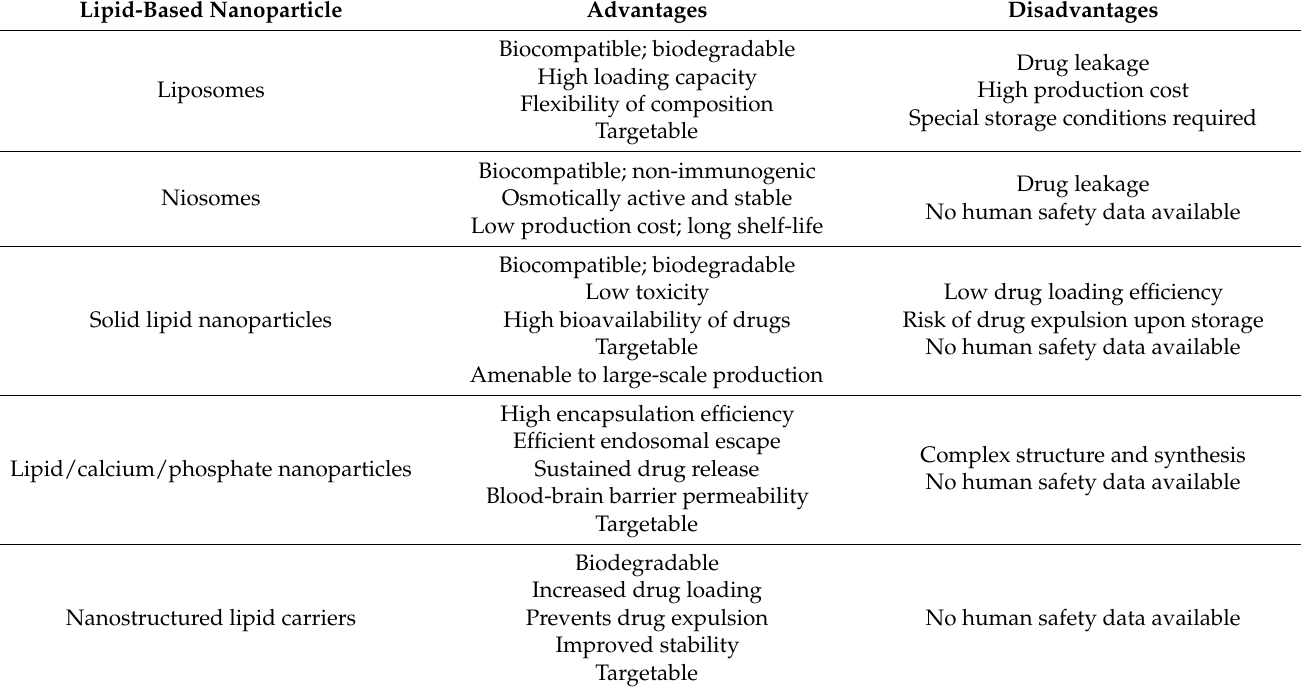
Table 1. Advantages and limitations of lipid-based nanoparticles as gemcitabine delivery agents. Lipid-Based Nanoparticle